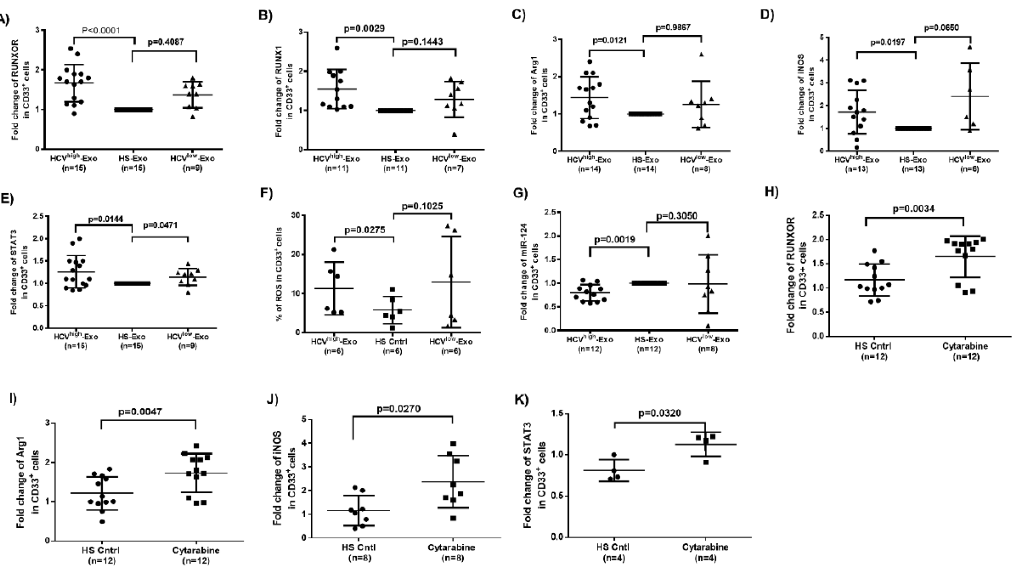
Figure 5. HCV-Exo or cytarabine treatment regulates lncRNA, miRNA, and mRNA expressions in MDSCs in vitro. ( A – G ) Expressions of RUNXOR, RUNX1, Arg1, iNOS, STAT3, ROS, and miR-124 in CD33 + cells treated with exosomes isolated from plasma of HCV-infected individuals (HCV high -Exo or HCV low -Exo) and HS (HS-Exo). ( H – K ) Cytarabine treatment induces the expression levels of RUNXOR, Arg1, iNOS, and STAT3 in HS-CD33 + cells.